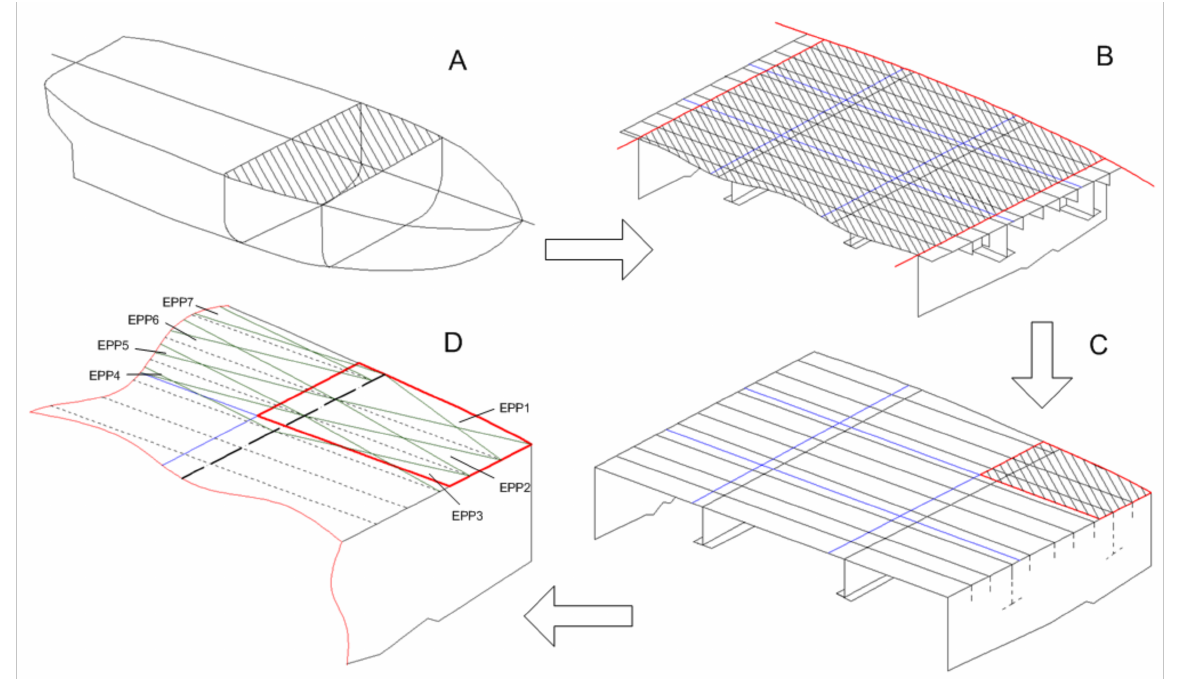
Figure 2. Sequence of steps for preparing data as applicable for elementary plate panel strength calculations. ( A ) selection of part of the structure; ( B ) consideration of the contour of structure boundaries and their strengthening topology; ( C ) determination of coordinates and calculation data for the of each plate; ( D ) determination of coordinates and calculation data for each EPP. Plate borders are shown in blue, in red—the borders of the selected plate or